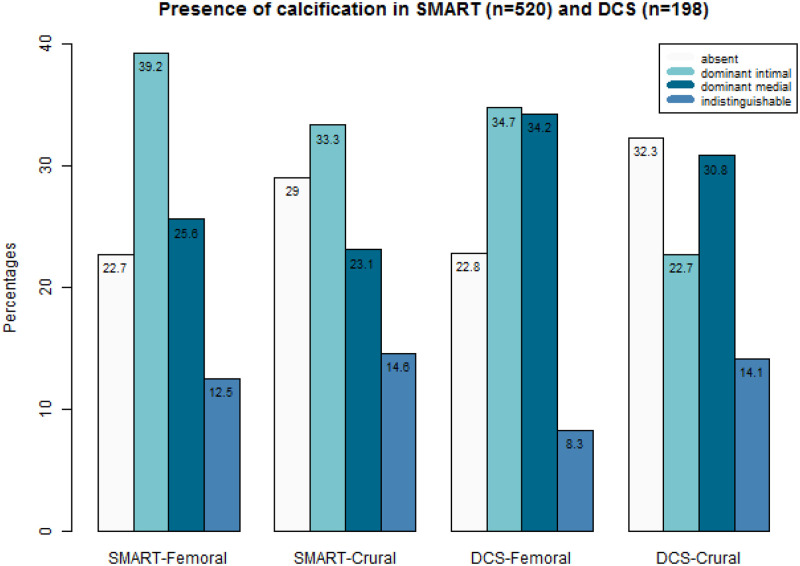
Frequencies of type of calcification in the femoral and crural arteries in the SMART (n = 520) and DCS (n = 198) cohort.